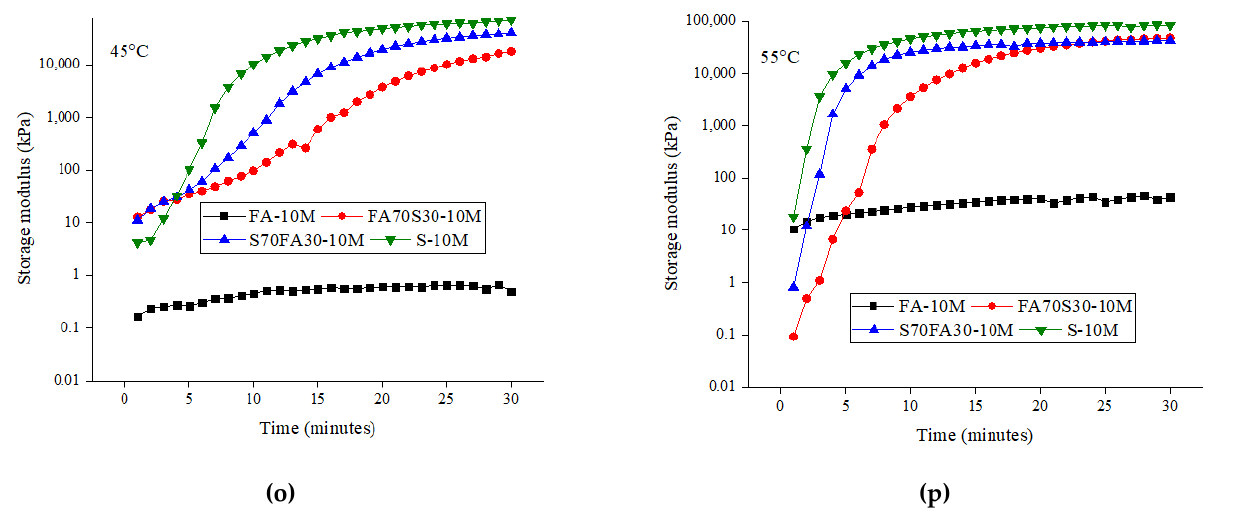
Figure 4. Evolution of storage modulus with time for alkali-activated mixes: ( a ) 4M at 25°C; ( b ) 4M at 35°C; ( c ) 4M at 45°C; ( d ) 4M at 55°C; ( e ) 6M at 25°C; ( f ) 6M at 35°C; ( g ) 6M at 45°C; ( h ) 6M at 55°C; ( i ) 8M at 25°C; ( j ) 8M at 35°C; ( k ) 8M at 45°C; ( l ) 8M at 55°C; ( m ) 10M at 25°C ( n ) 10M at 35°C ( o ) 10M at 45°C; ( p ) 10M at 55°C.